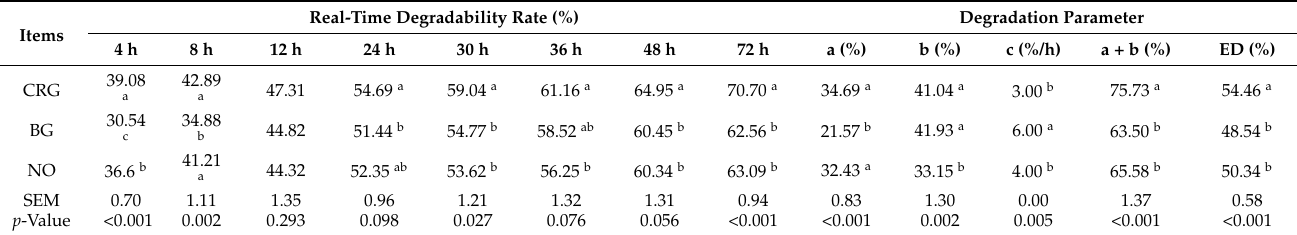
Table 7. Rumen real-time degradability and degradation parameters of CP for three forages (CRG, BG, and NO).